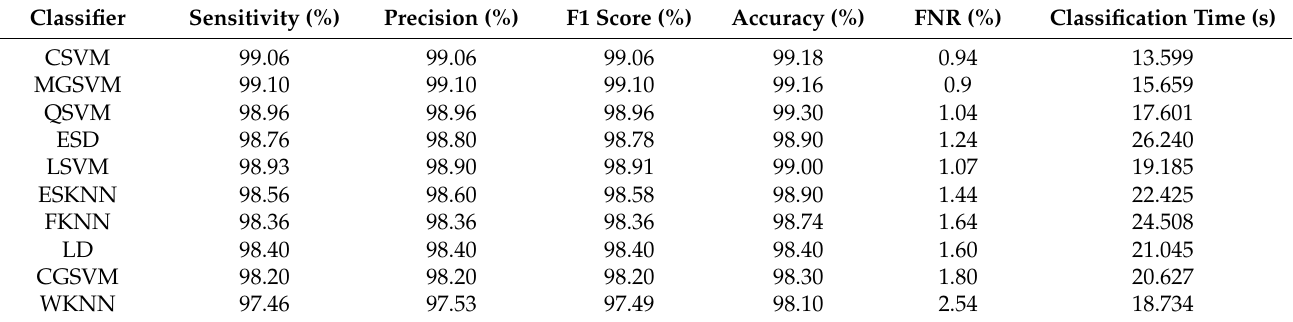
Table 7. Classification results using the feature fusion of DE and BGWO using ultrasound images, where the training/testing ratio is 50:50.